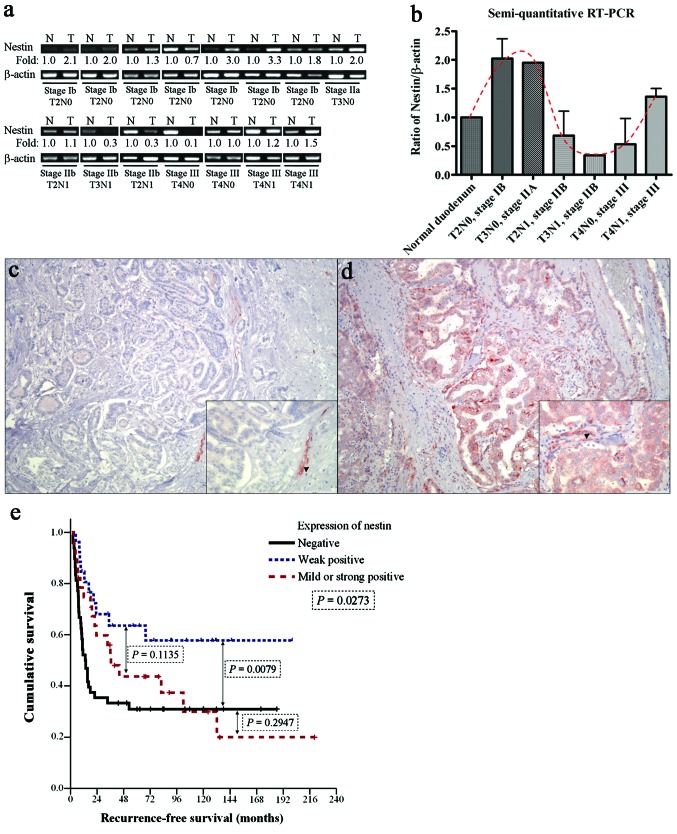
Expression of nestin in ampullary adenocarcinoma by semi-quantitative RT-PCR and immunohistochemistry (IHC) staining. (a) Fresh tissue samples from ampullary adenocarcinoma (T) and corresponding normal duodenum (N) were collected from different stages of disease. A total of 15 pairs of samples were assessed. β-actin served as a loading control. The fold-change of nestin/β-actin is labeled below the band. (b) The cancer/normal proportion of nestin/β-actin expression is correlated with pathological stage. (c and d) Expression of nestin in ampullary adenocarcinoma by IHC staining. The main images were captured at ×100 magnification, and the small images located at the right lower quadrant of each figure were captured at ×400. (c) Negative expression of nestin in ampullary adenocarcinoma (T2N1, stage IIB). The arrowhead indicates new lymphatic ducts or vessels within the tumor. (d) Dense expression of nestin in ampullary adenocarcinoma (T3N0, stage IIA) and a lymphovascular duct, indicated by an arrowhead in the magnified view. (e) Kaplan-Meier recurrence-free survival analysis of nestin expression in patients with ampullary adenocarcinoma (log-rank test) (P=0.0041). Solid black line represents the survival curve of patients with negative expression of nestin, fine dotted blue line represents the survival curve of patients with weak positive expression of nestin and the coarse dotted red line represents the survival curve of patients with mild to strong positive expression of nestin